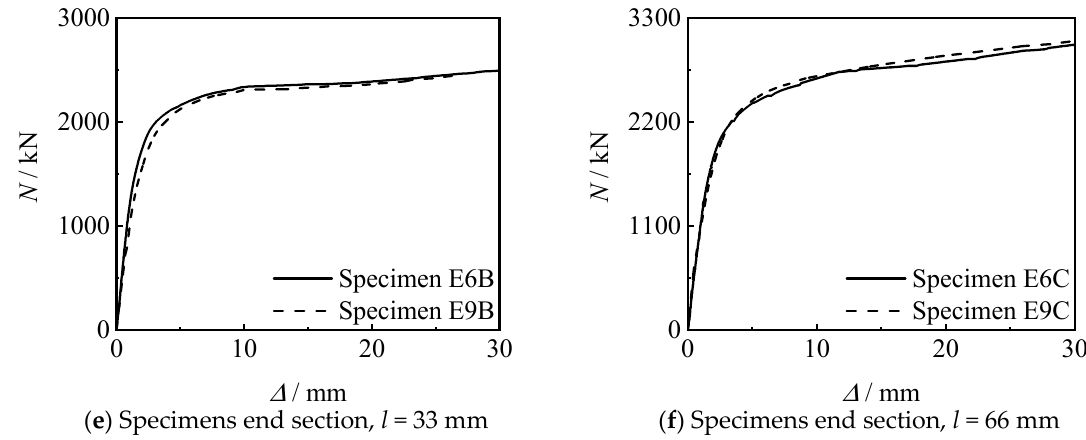
Figure 14. Effect of thread depth on N- Δ curves of specimens.